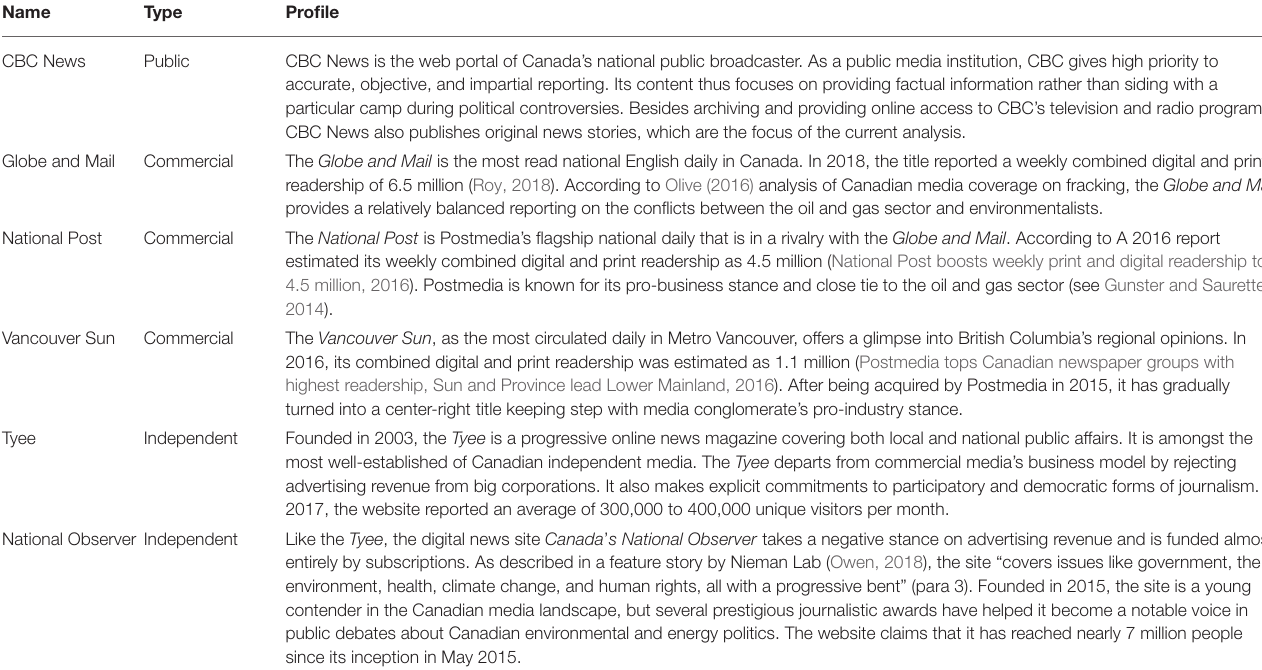
TABLE 1 | Profiles of target media